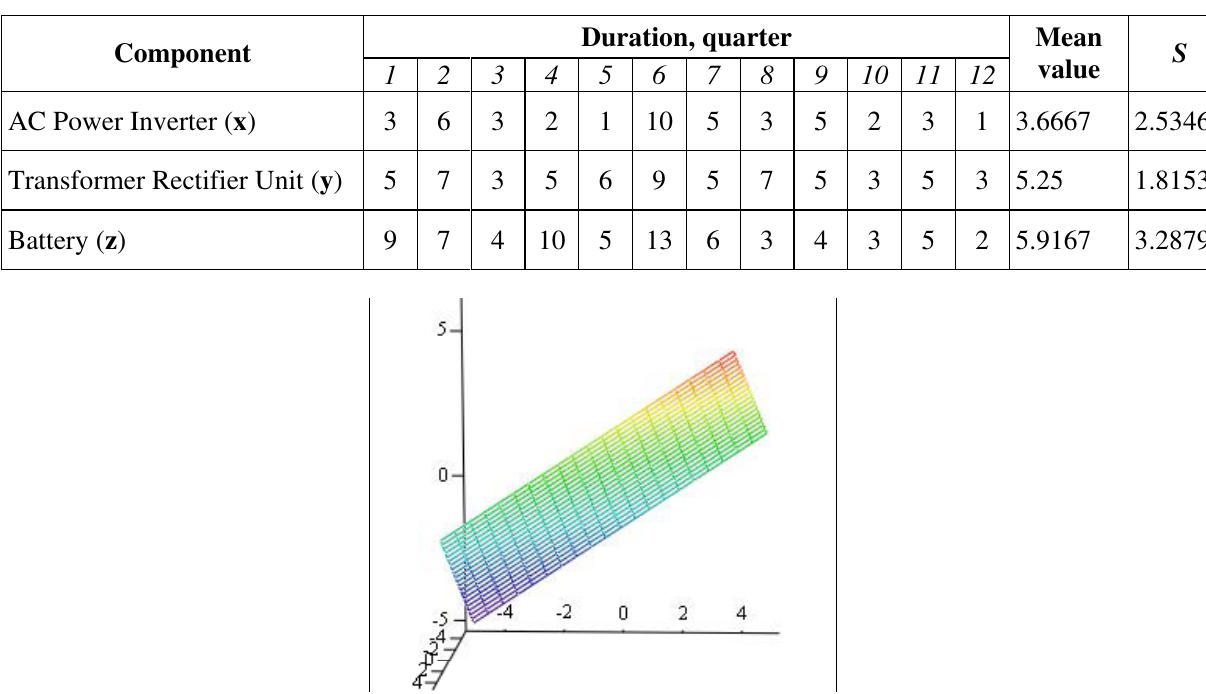
Table. Data of mutually dependant components